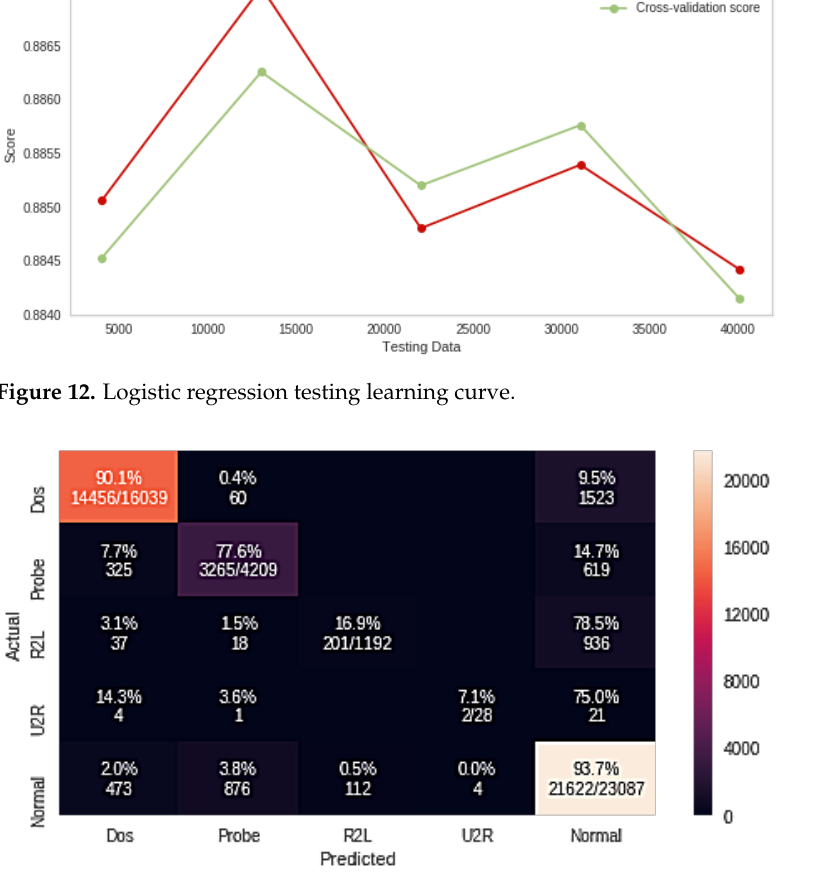
Figure 13. Logistic regression confusion matrix.